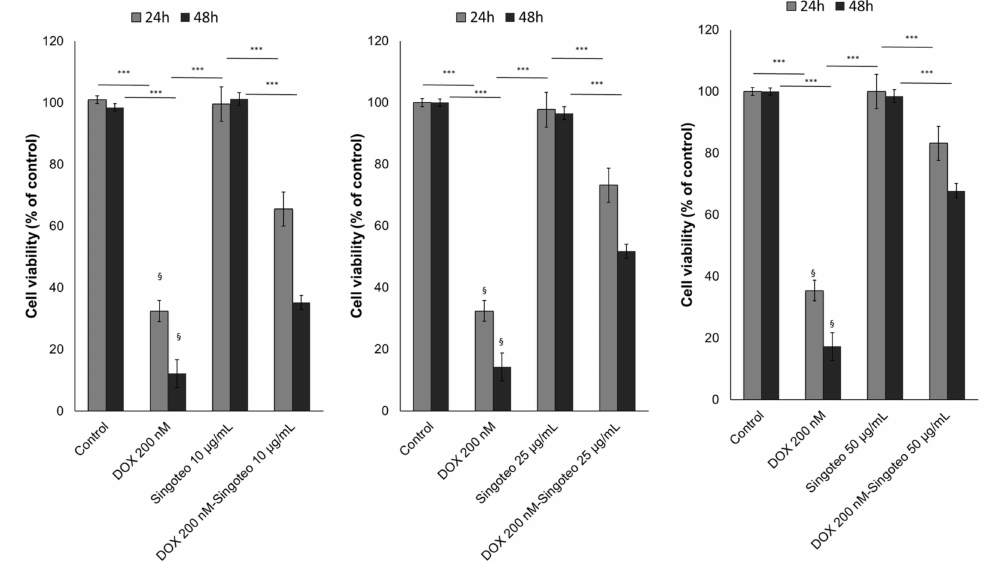
Figure 10. Cell viability of human cardiomyocytes exposed to DOXO at 200 nM, Singo at 10, 25 and 50 µ g/mL, or both in combination for 24 and 48 h. Results: mean +/ − SD. *** p < 0.001. §: p < 0.001 between the DOXO 200 nM group and DOXO 200 nM associated with Singo 10 µ